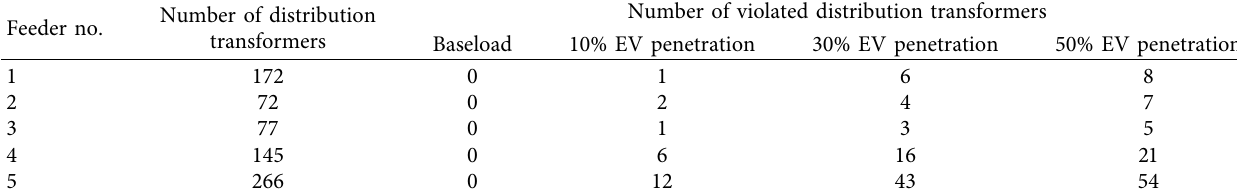
Table 5: Number of distribution transformers that violate the security constraint in planning criteria for uncoordinated charging. Feeder